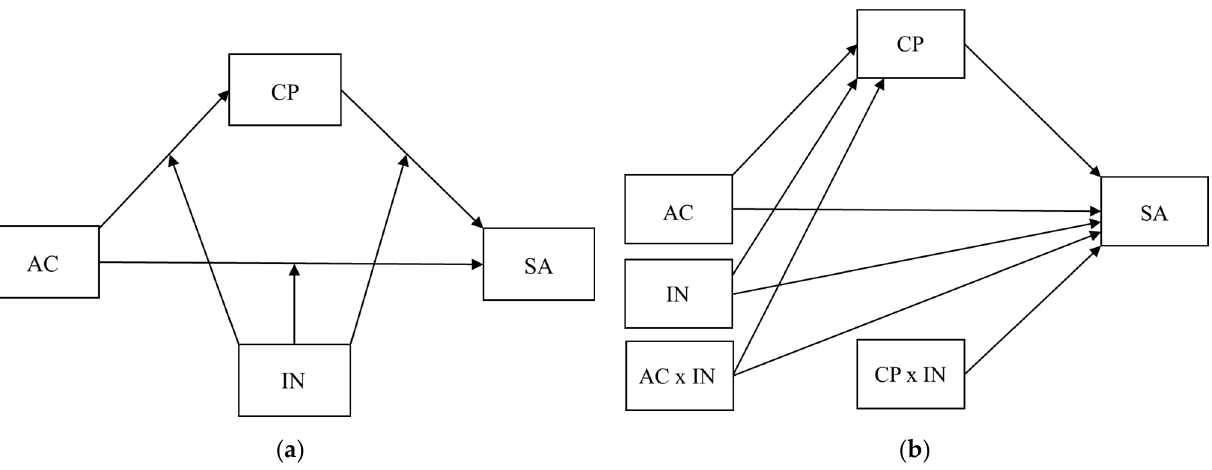
Figure 1. Moderated mediation model tested in the present study: ( a ) conceptual diagram; ( b ) statistical diagram. Note . AC = appetitive cyberaggression, CP = cyberbullying perpetration, SA = social media addiction, IN = inclusive norms.